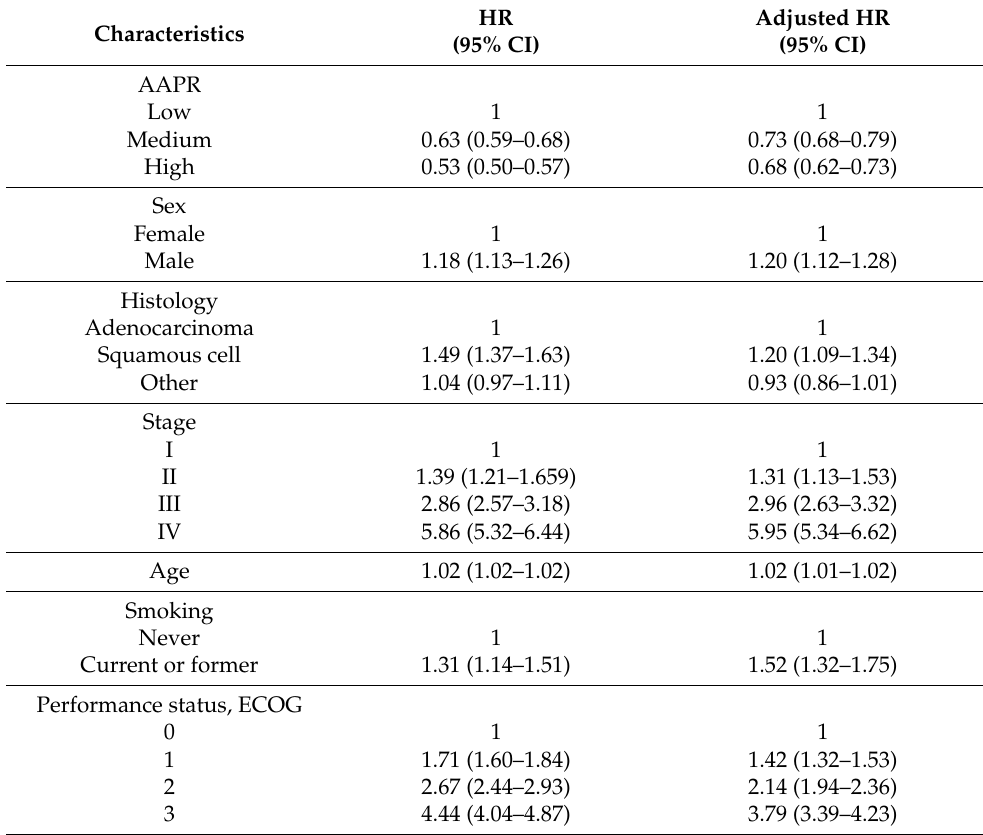
Figure 2. Kaplan-Meier curves of overall survival (OS) according to pretreatment AAPR level for patients with non-small cell lung cancer and small cell lung cancer: ( A ) OS according to AAPR level in non-small cell lung cancer. Patients were divided by applying tertiles (low AAPR < 0.3485, medium AAPR 0.3485–0.5067, and high AAPR > 0.5067); ( B ) OS according to AAPR level in small cell lung cancer. Patients were divided into tertiles (low AAPR < 0.3483, medium AAPR 0.3483–0.5067, and high AAPR > 0.5067). The log-rank test estimated differences between groups. AAPR, albumin-to-alkaline phosphatase ratio; CI, confidence interval. Table 2. Univariate and multivariate analyses of overall survival in non-small cell lung cancer patients ( N =